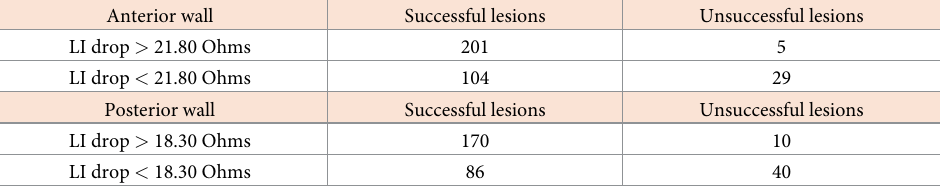
Table 3. The number of successful and unsuccessful lesions used for sensitivity, specificity and predictive value calculation. Applications below and above the LI cut-points are shown separately to enable the identification of true positive and negative, false positive and negative